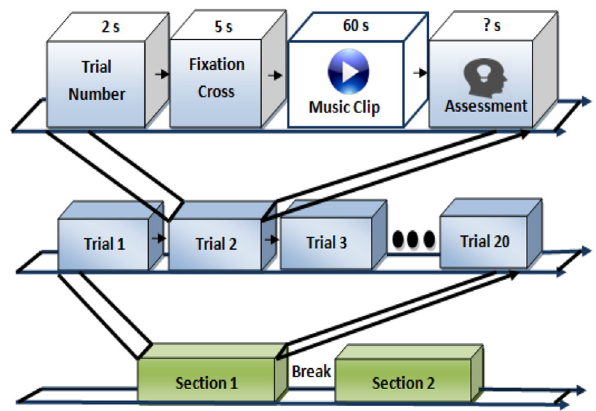
Fig. 2 Paradigm applied to record EEG signals from participants